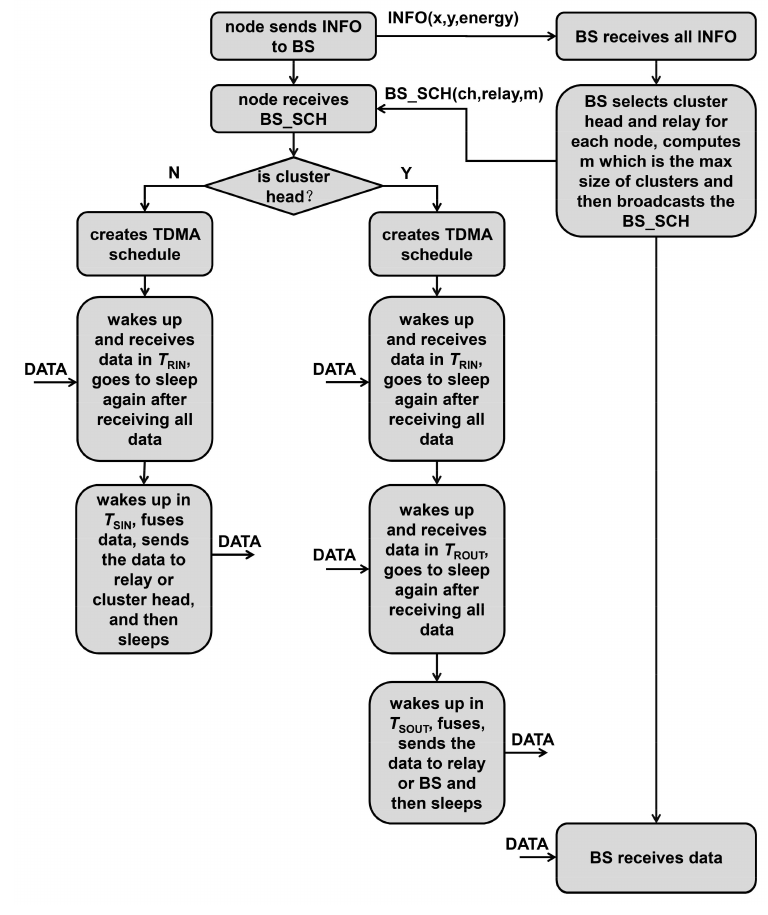
Figure 8. The protocol flow.